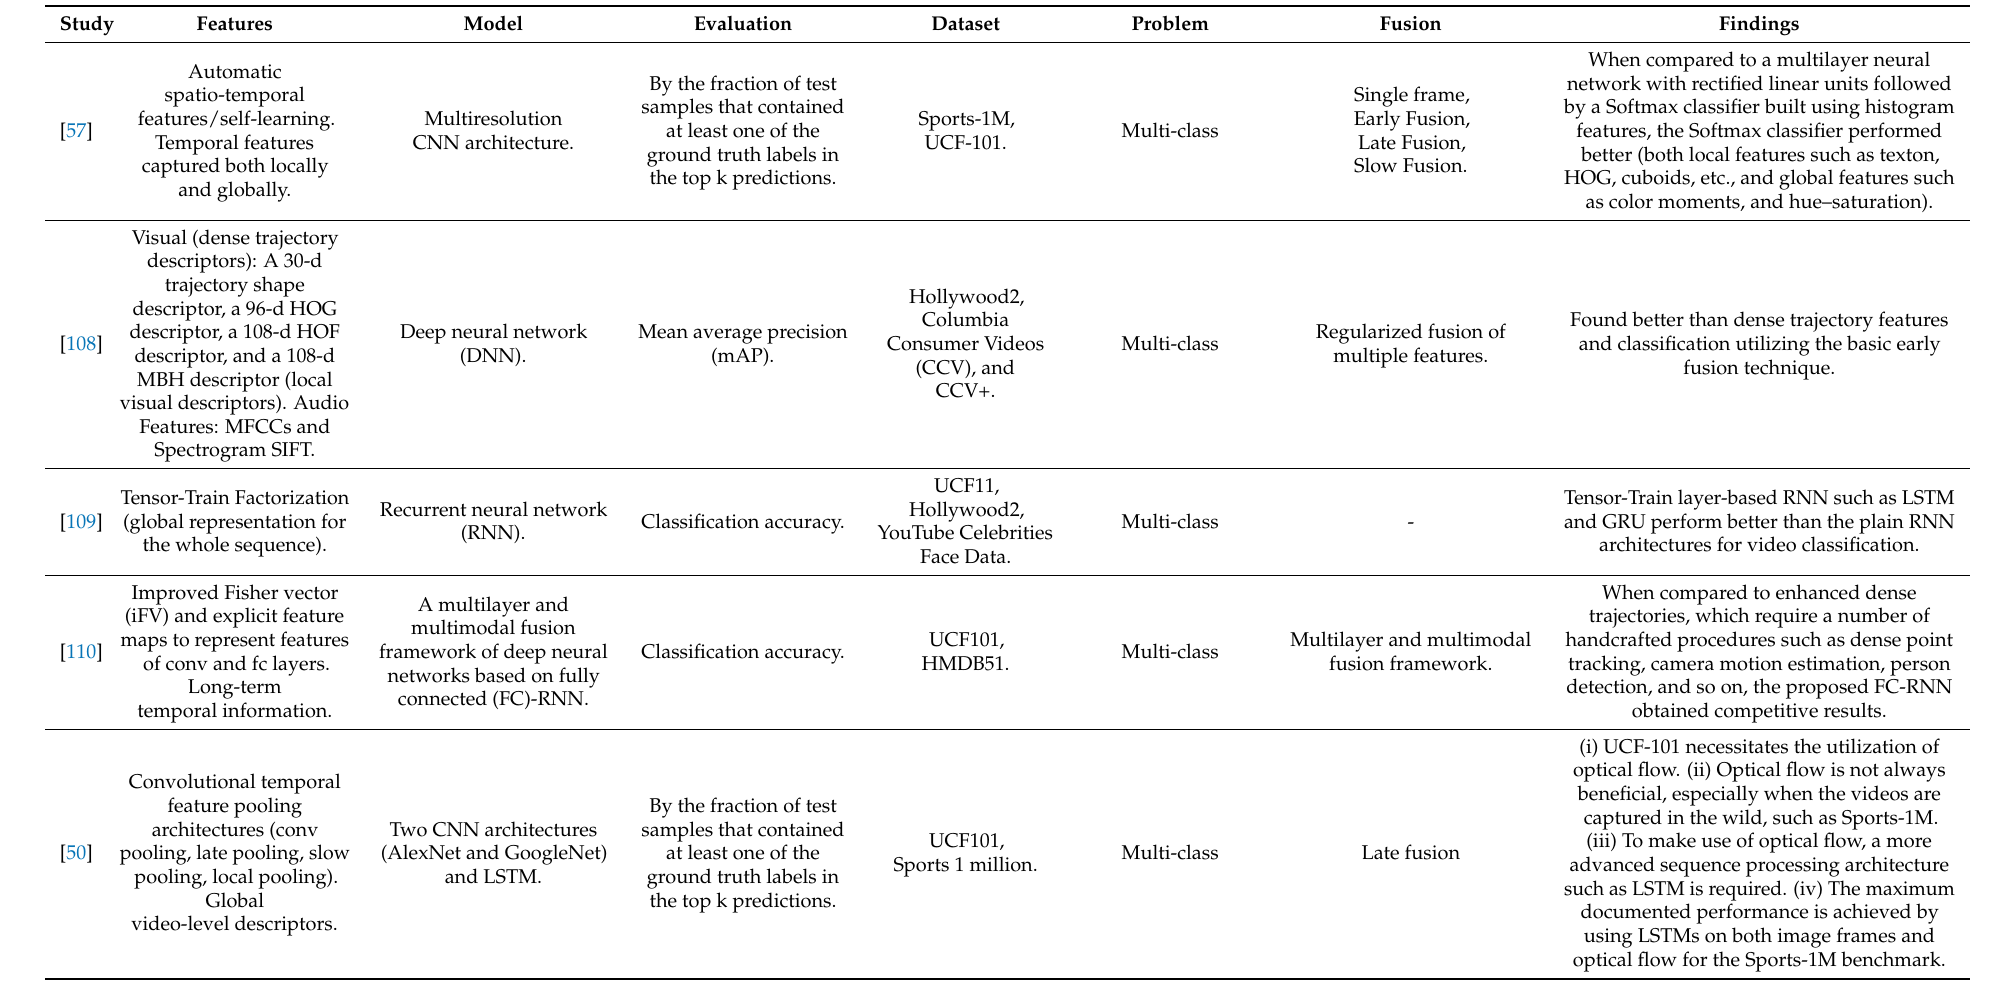
Table 3. Summary and findings of studies based on deep learning